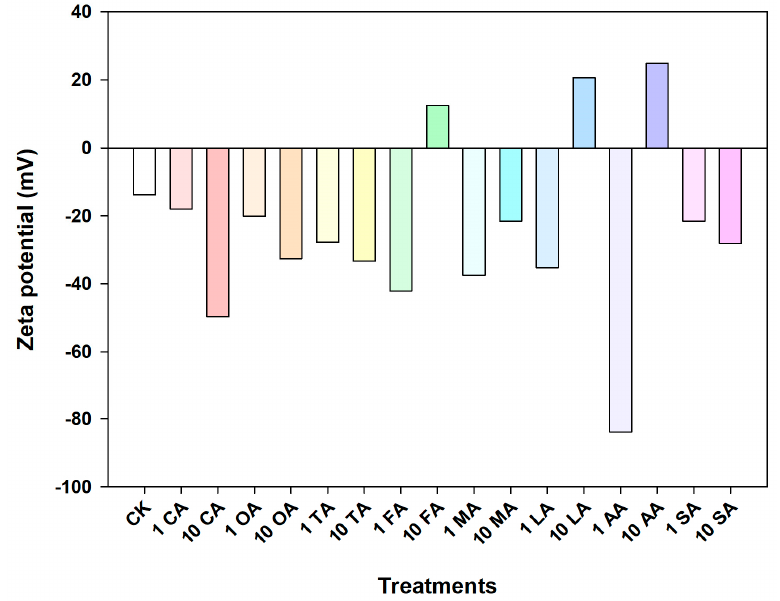
Figure 3. Zeta potential of CuO NPs (100 mg/L) in aqueous solutions with different LMWOAs.